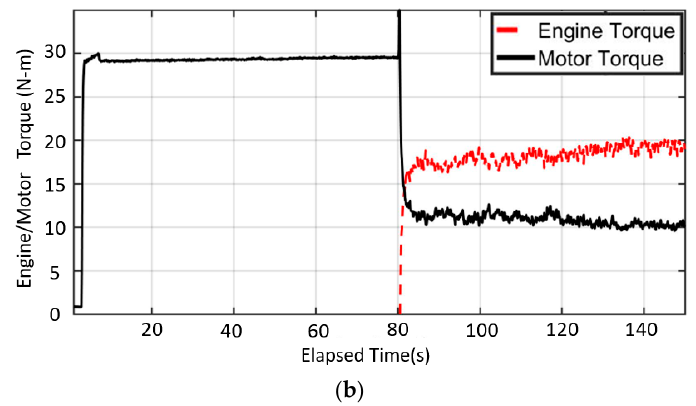
Figure 10. Engine/hub motor hybrid mode: ( a ) speed; ( b ) torque .